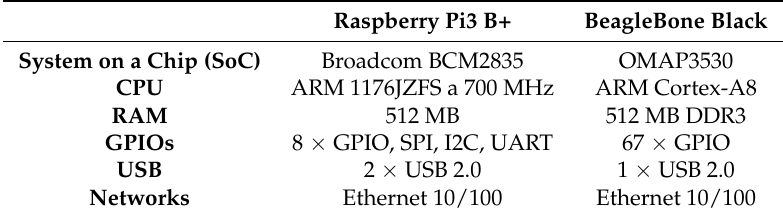
Table 1. Raspberry Pi3 B+ (RPI3 B+) and BeagleBone Black (BBB) electrical characteristics. GPIO: general-purpose I/O port.